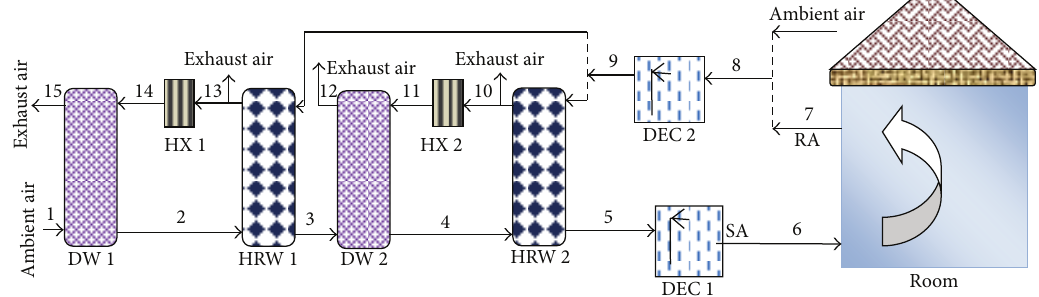
Figure 3: Schematic of two-stage solar desiccant cooling system-ventilation mode.